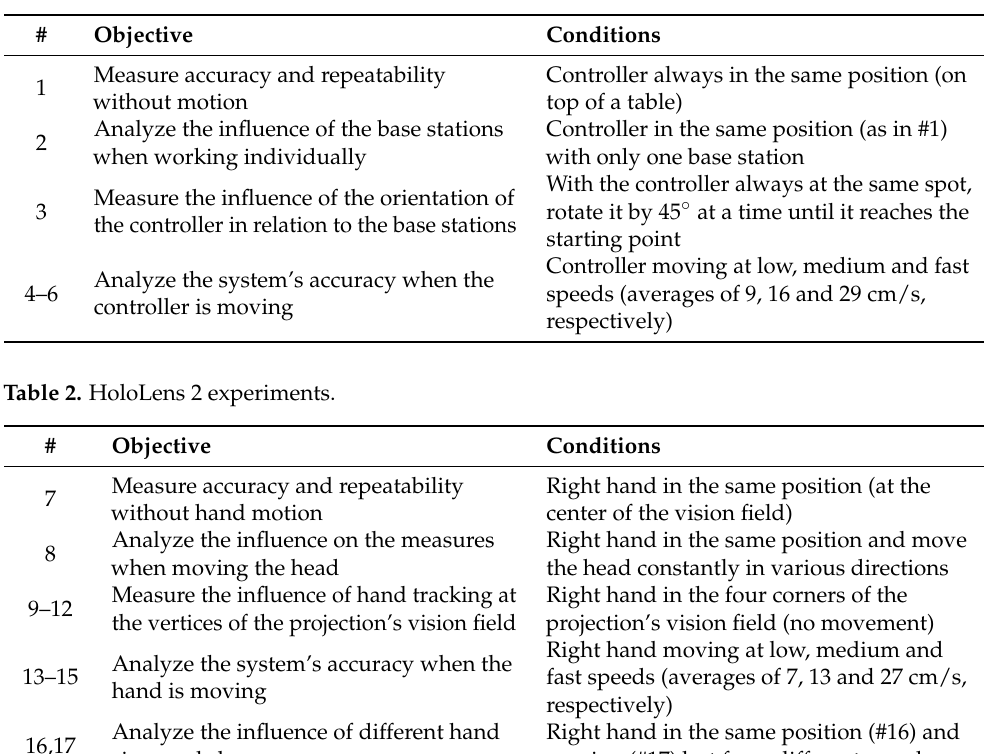
Table 1. HTC Vive experiments.